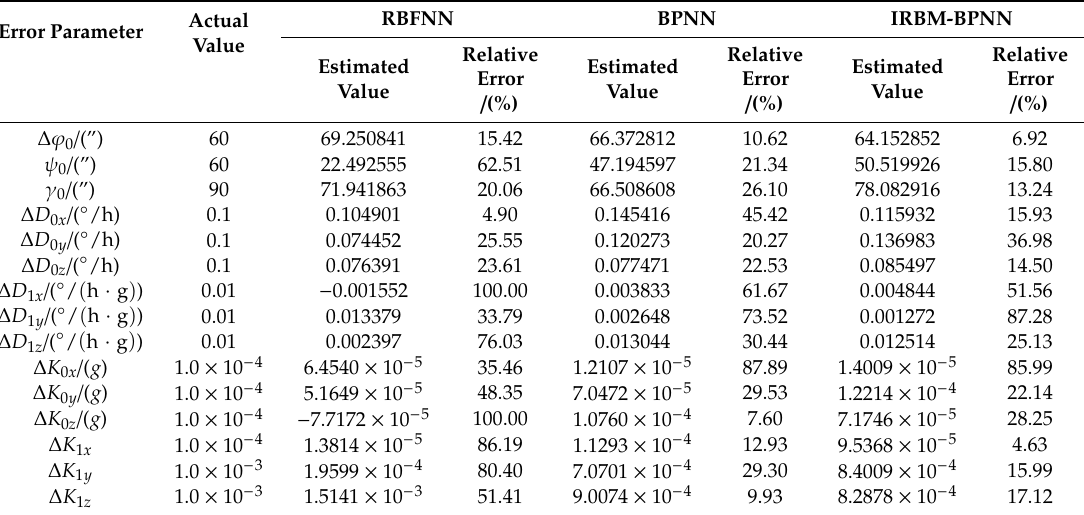
Table 5. Forecast results of error parameter settings by three